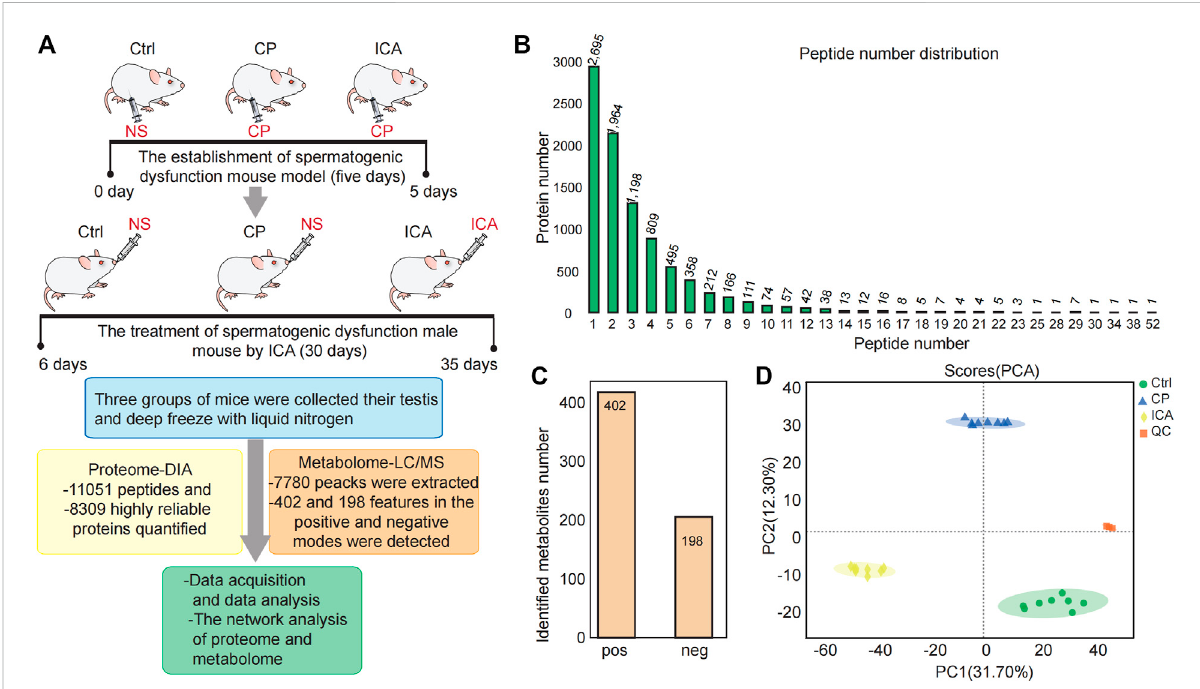
FIGURE 2 Overview of the testis proteomics and metabolimics analysis. (A) Experiment Work fl ow. Three groups — The Ctrl group injected with Normal saline (NS) ( n = 10), Mod group injected with cyclophosphamide (CP) ( n = 10), ICA group injected with cyclophosphamide in building models of spermatogenesis dysfunction ( n = 10), were used in this study. The ICA treatment group to 80 mg/(kg.d) ICA irrigation stomach for 30 days. The normal and the model groups each received an equivalent NS. The testis tissue was obtained for omic platforms applied and analysis. (B) Distribution of peptide number in three groups. (C) Number of characterized metabolites in the Ctrl, CP and ICA samples. (D) Principal component analysis (PCA) of the quanti fi ed metabolites for each